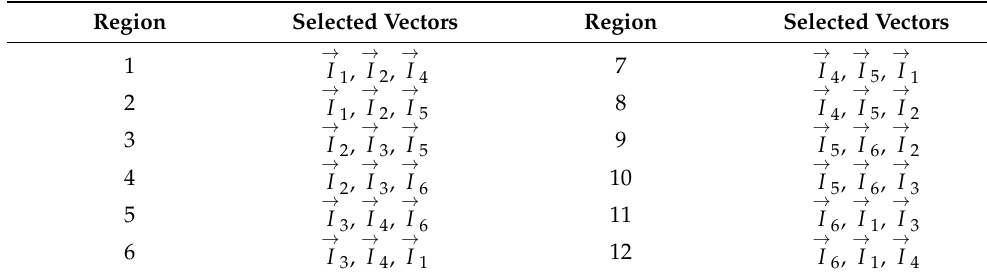
Figure 5. Amplitude of control frequency component in CMV with proposed AZS-SVM in region 1 and region 2. Table 1. Selected space vectors in different regions.